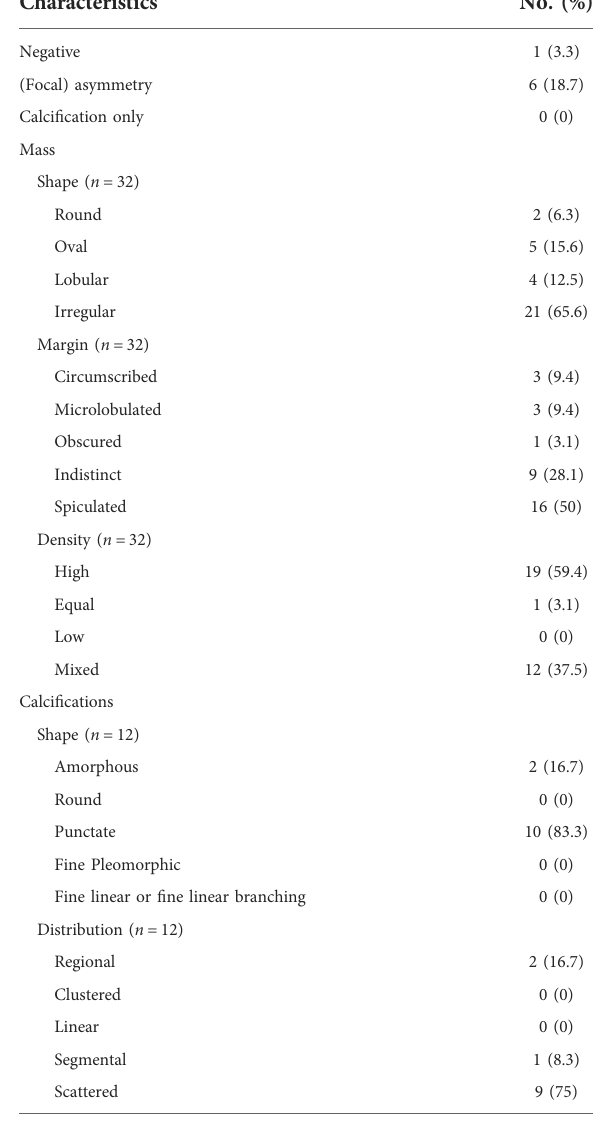
TABLE 2 Mammographic characteristics of IMPC lesions ( n =32). TABLE 1 Patient characteristics ( n